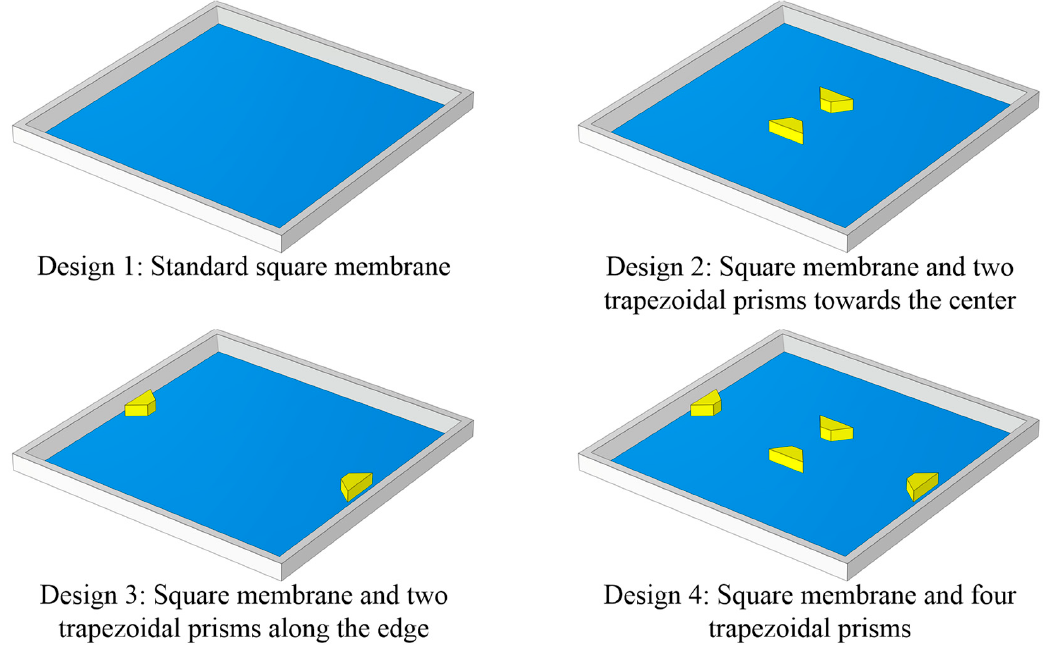
Figure 4. Four distinct designs of structures.